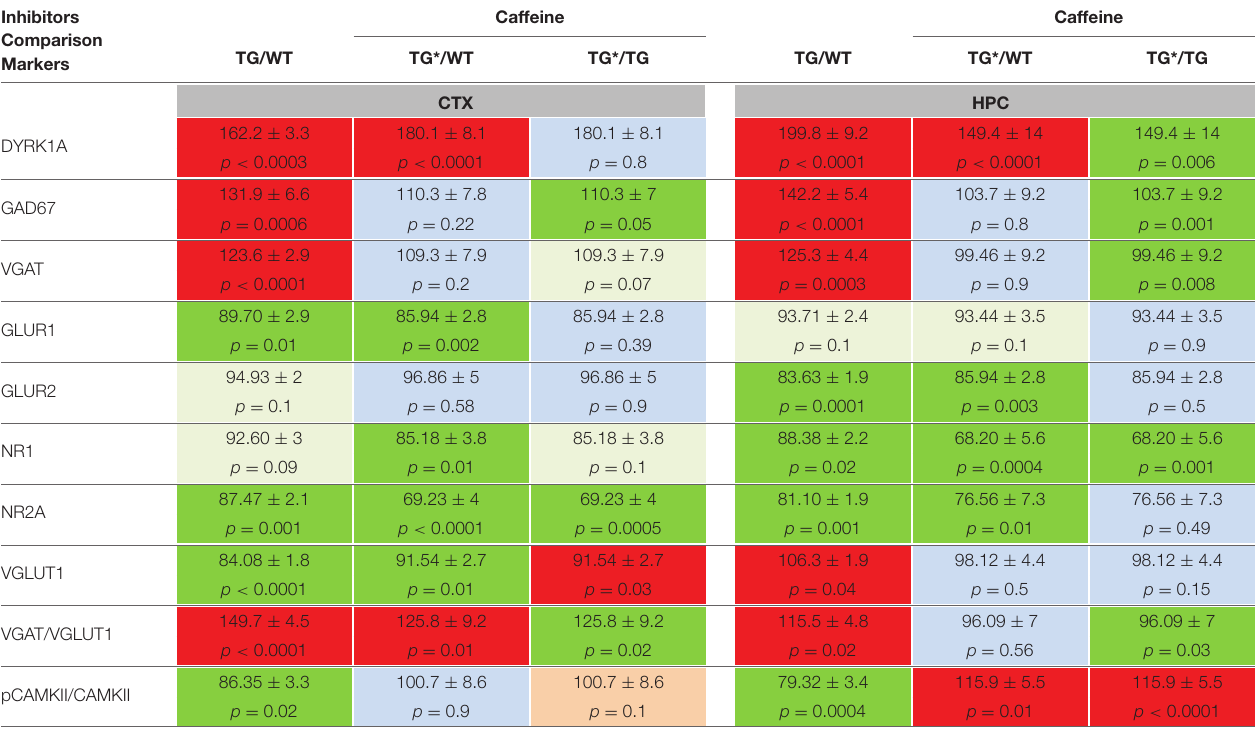
TABLE 6 | Protein levels of markers of inhibition and excitation pathways for WT and mBACtgDyrk1a (Tg) in cortex and hippocampus following treatment with caffeine. Inhibitors Comparison